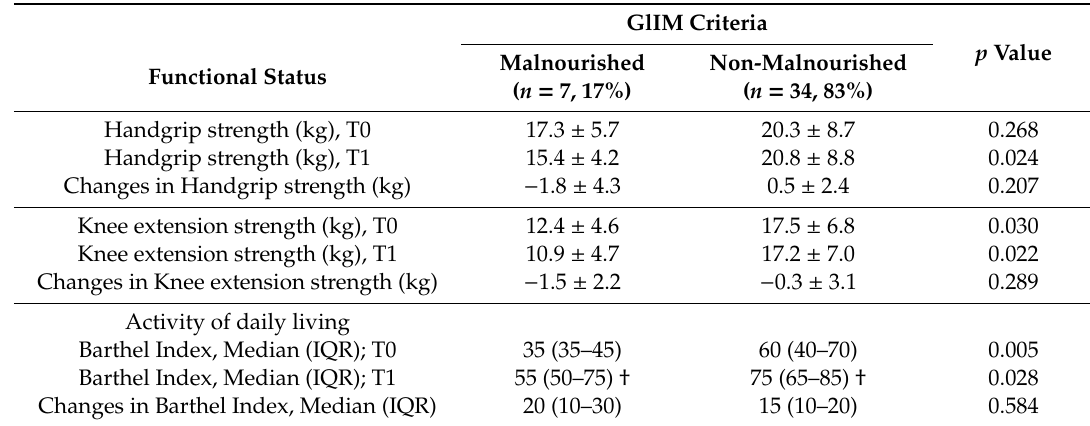
Table 3. Comparison of functional status of study population stratified by nutritional status at baseline (T0) and follow-up (T1) and the respective changes.